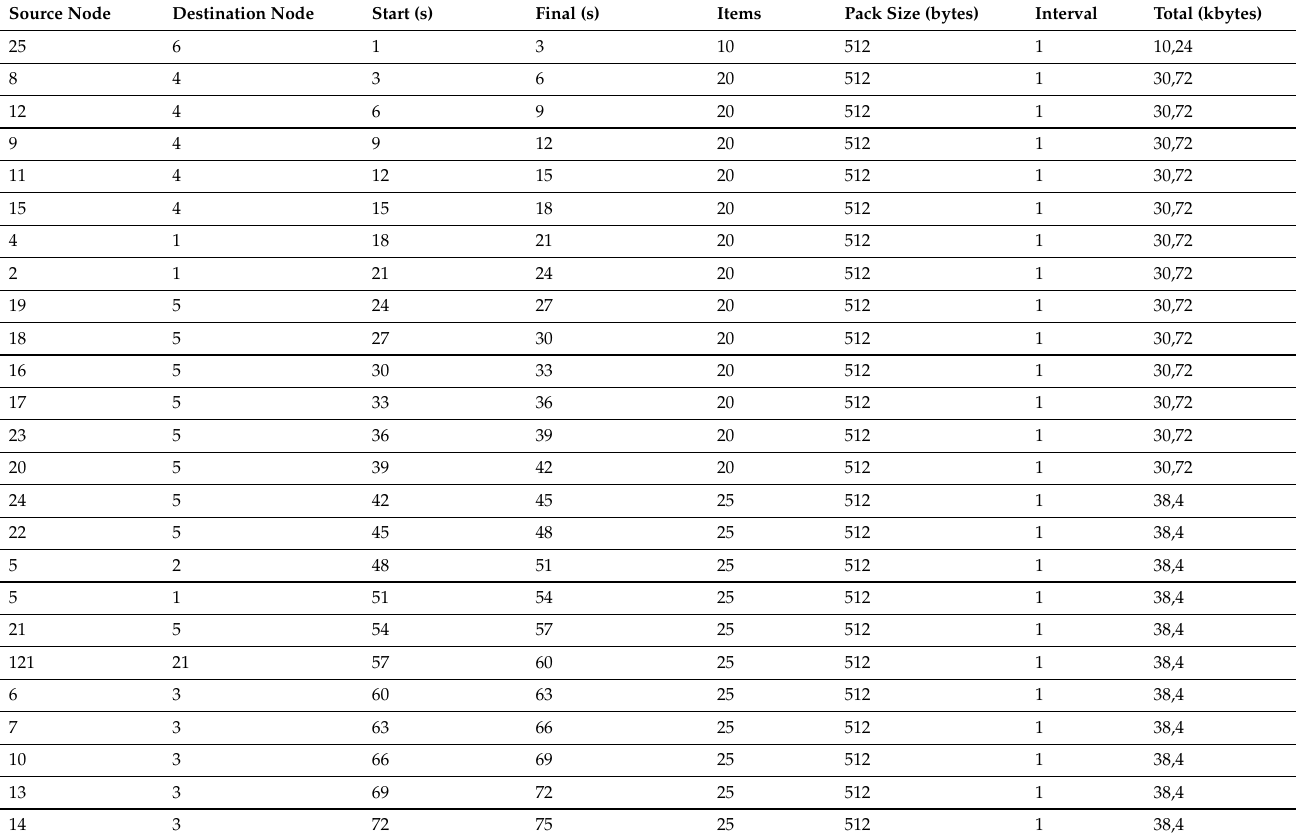
Table 6. Constant bit rate between nodes—Zigbee